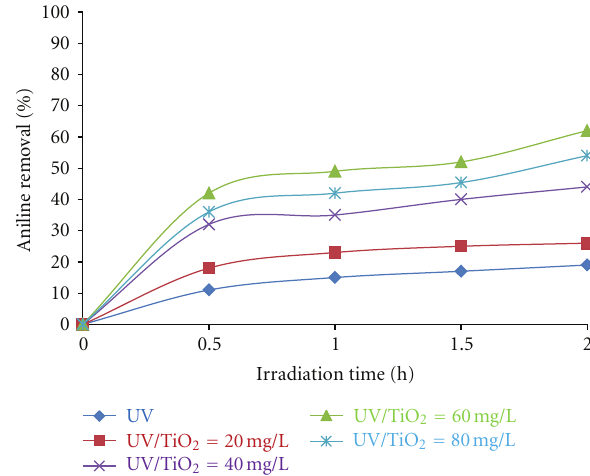
Figure 2: E ff ect of catalyst concentration on aniline removal (initial pH: 6, temperature ( T ): 293 K).